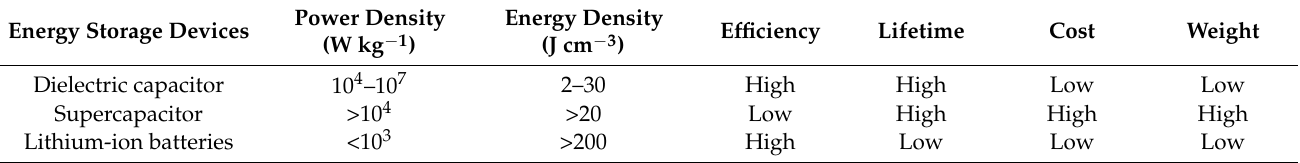
Table 1. Comparison of performance indicators for a variety of energy storage